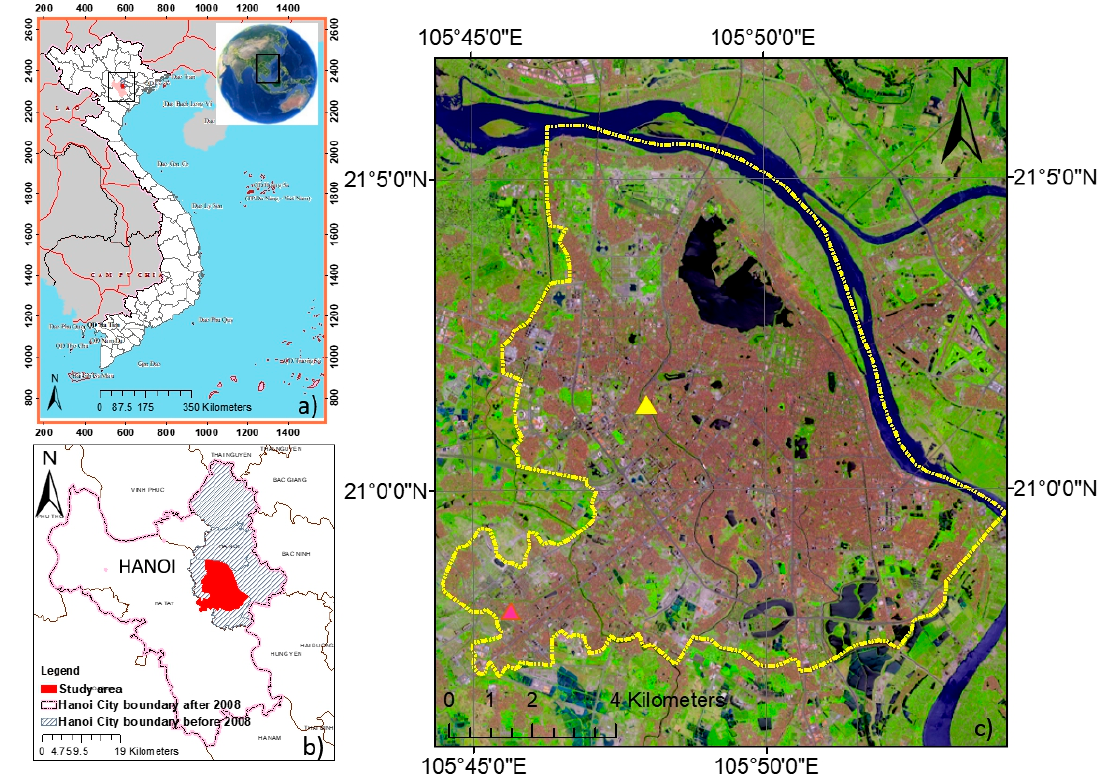
Figure 1. Location of the study area: ( a ) Location of the study area in Vietnam; ( b ) detail of the study area with the boundary of Hanoi City before and after 2008; ( c ) inner Hanoi city (yellow polygon) on the composited Landsat 8 satellite image acquired on 4 June 2017, and locations of the meteorological stations Lang (yellow) and Ha Dong (orange) used to acquire air temperature data.